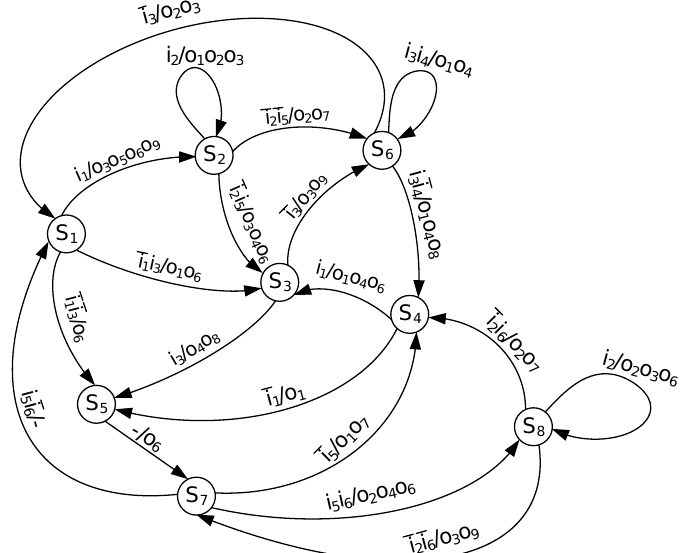
Figure 6. State transition graph of Mealy FSM Ex2.